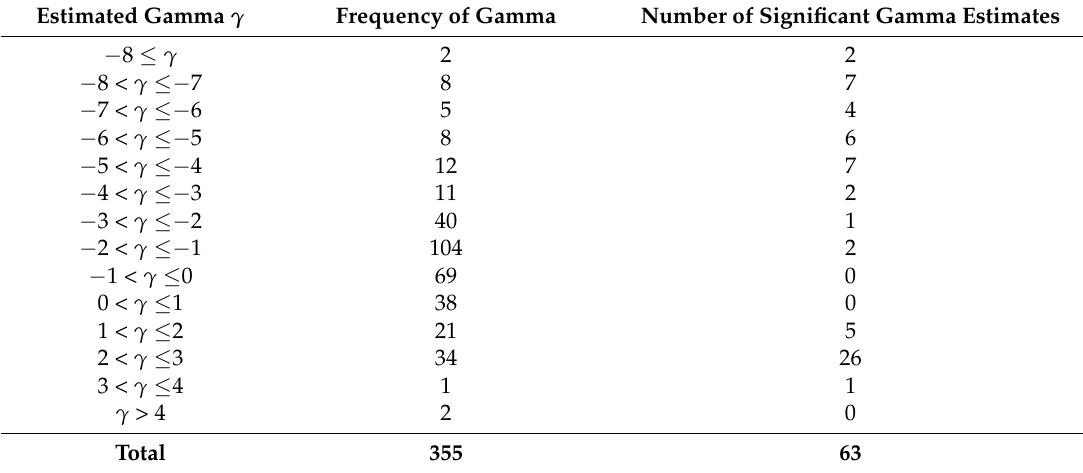
Table 3. Distribution of market timing ability for each of the 355 funds between April 2011 and April